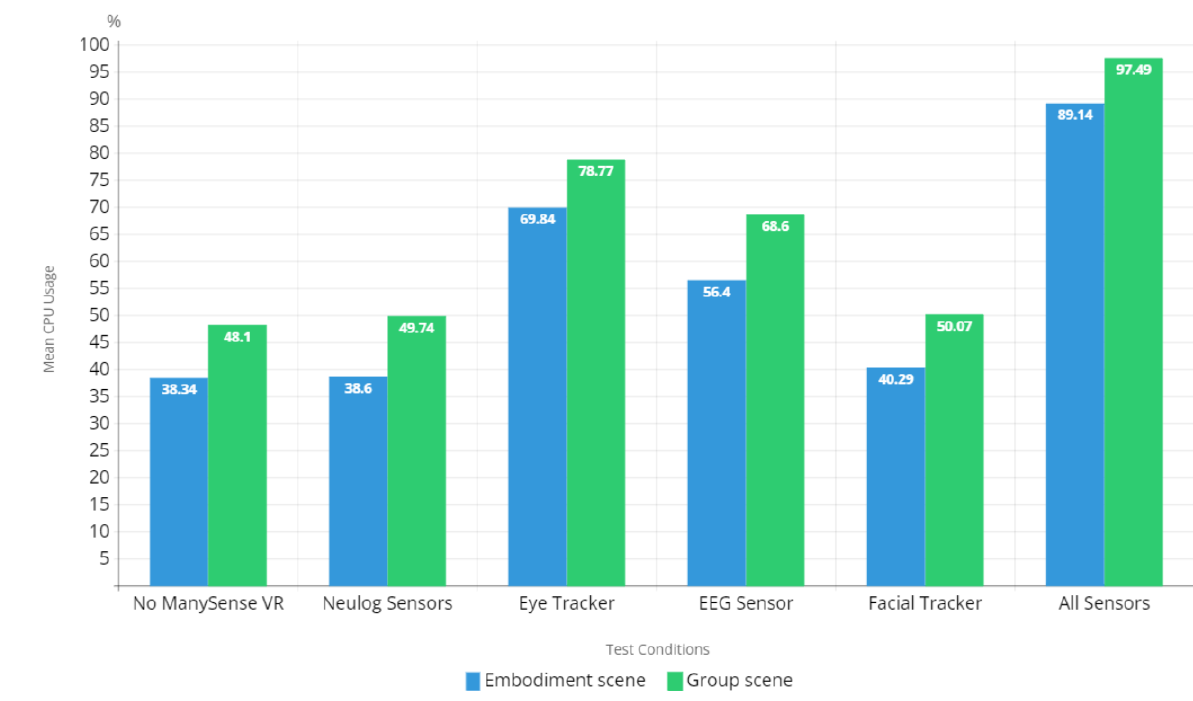
Figure 10. Mean CPU usage (%) for each test condition and scene.